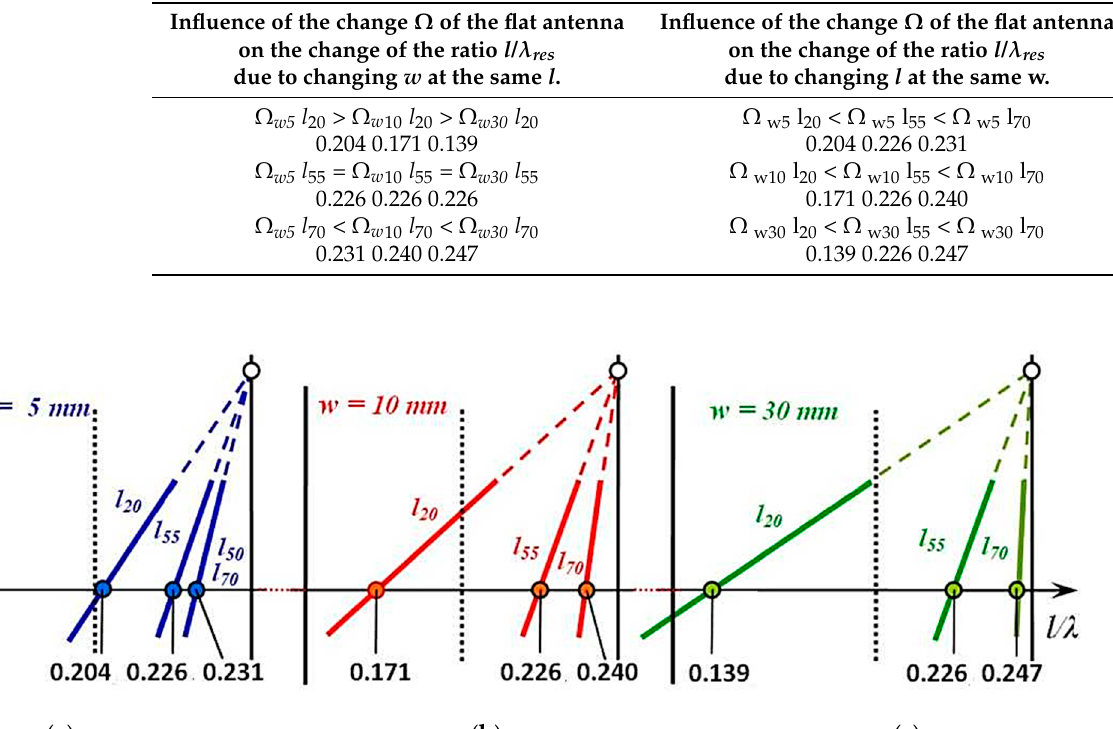
Table 4. Values of resonance points l / λ res of flat microwave antennas.